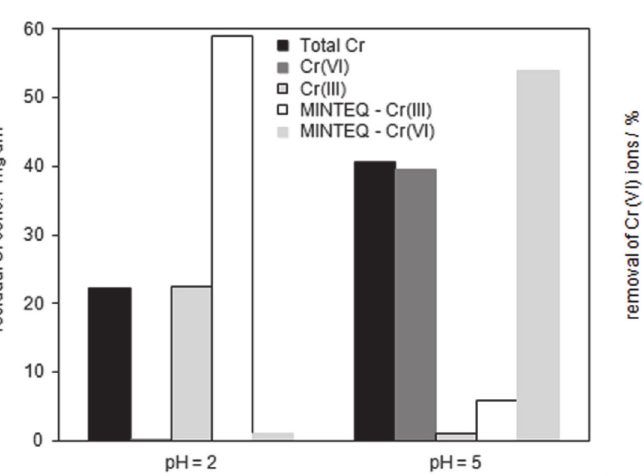
Fig. 6 – Effect of adsorbent concentration on removal of Cr(VI) by grape and olive waste during 240 min (γ